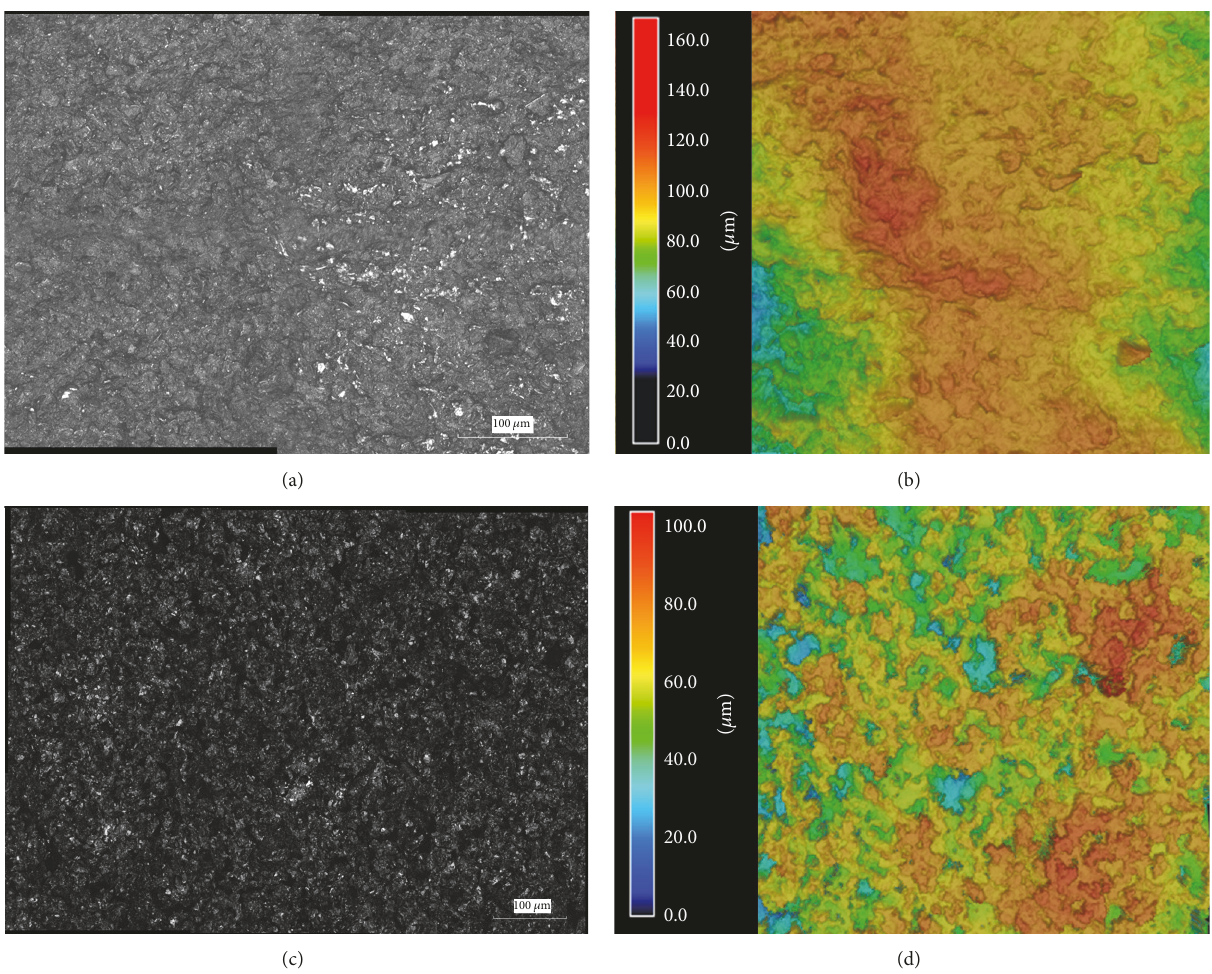
Figure 7: (a, b) Laser microscope and 3D topography images of oven-cured F1 and (c, d) photonic-cured F2.